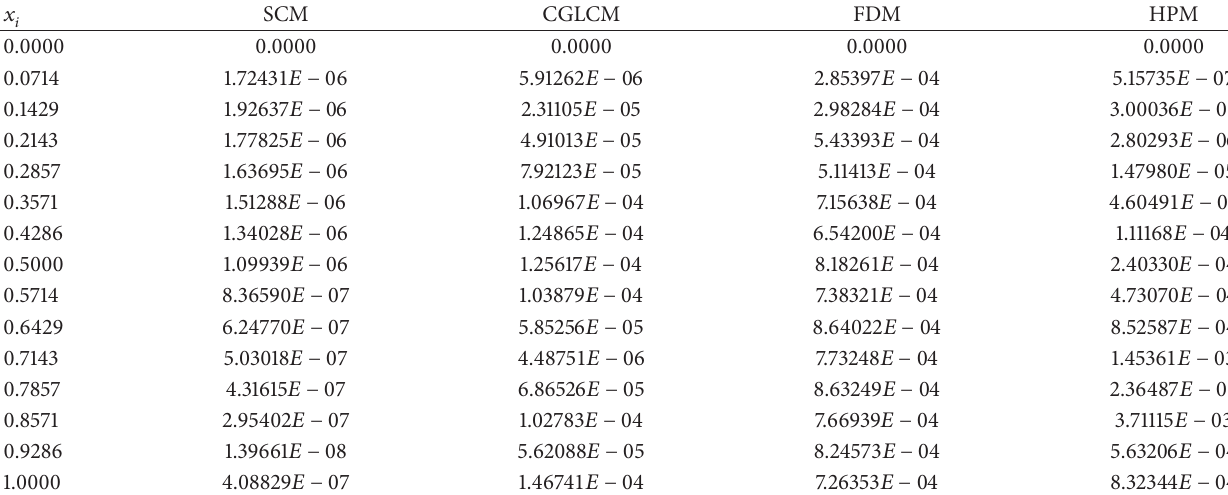
Table 2: Comparison of absolute errors for Problem 1